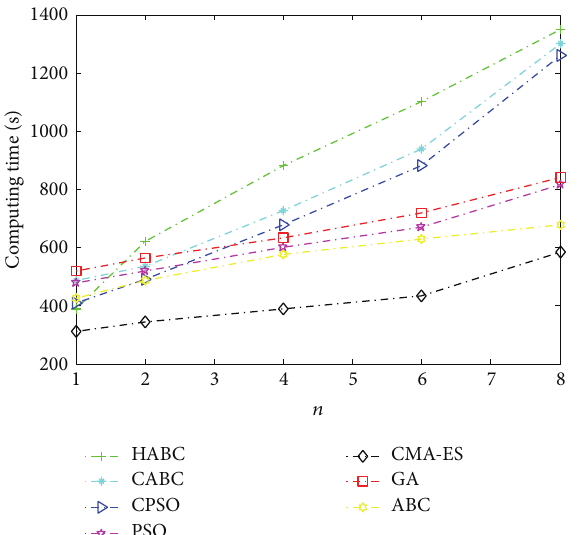
Figure 8: Computing time of all algorithms on different RNP